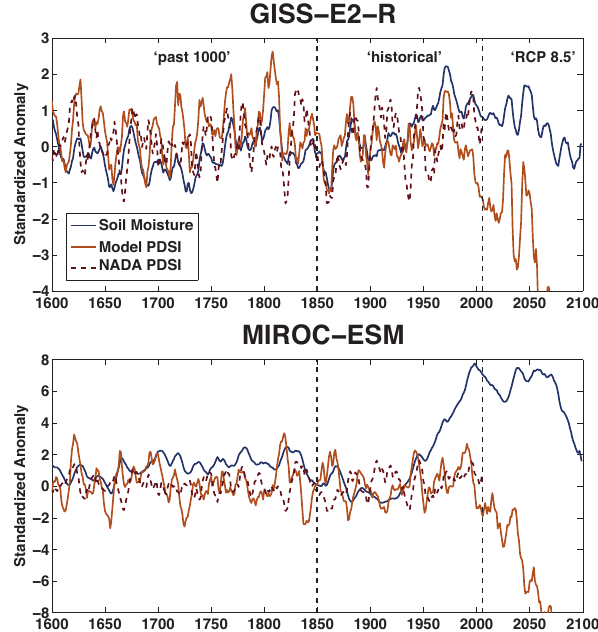
Fig. 13. Standardised anomalies for PDSI and soil moisture in two models (GISS-E2-R and MIROC-ESM) using a past1000 sim- ulation, and a historical + rcp85 continuation. For reference, the tree-ring-based reconstruction is plotted (dashed line) (Cook et al., 2010), though this would not be expected to line up exactly with the model simulations. All data smoothed with a 10yr running